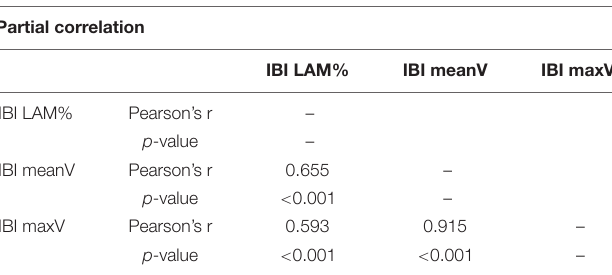
TABLE 3 | Correlation matrix, laminarity, mean and maximum vertical line length on the triad level during group